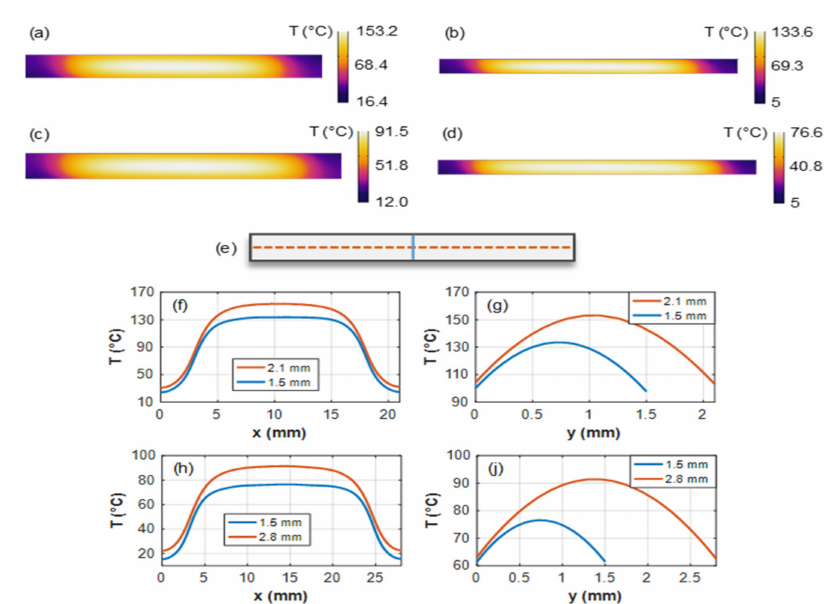
Figure 8. Simulated temperature distribution in one Ti:Sa crystal from the twin-TD arrangement for 2.1 mm ( a ) and 1.5 mm ( b ) thicknesses with 21 mm diameter and 1 J/cm 2 pump fluence per crystal, also for 2.8 mm ( c ) and 1.5 mm ( d ) thicknesses with 28 mm diameter and 0.5 J/cm 2 pump fluence. Cross sections in the Ti:Sa crystal are represented by blue and orange curves in ( f – i ) parts of the figure ( e ). Temperature profiles in the cross sections of the Ti:Sa disk for 1 J/cm 2 ( f , g ) and 0.5 J/cm 2 ( h , i ) energy fluences for the two different disk